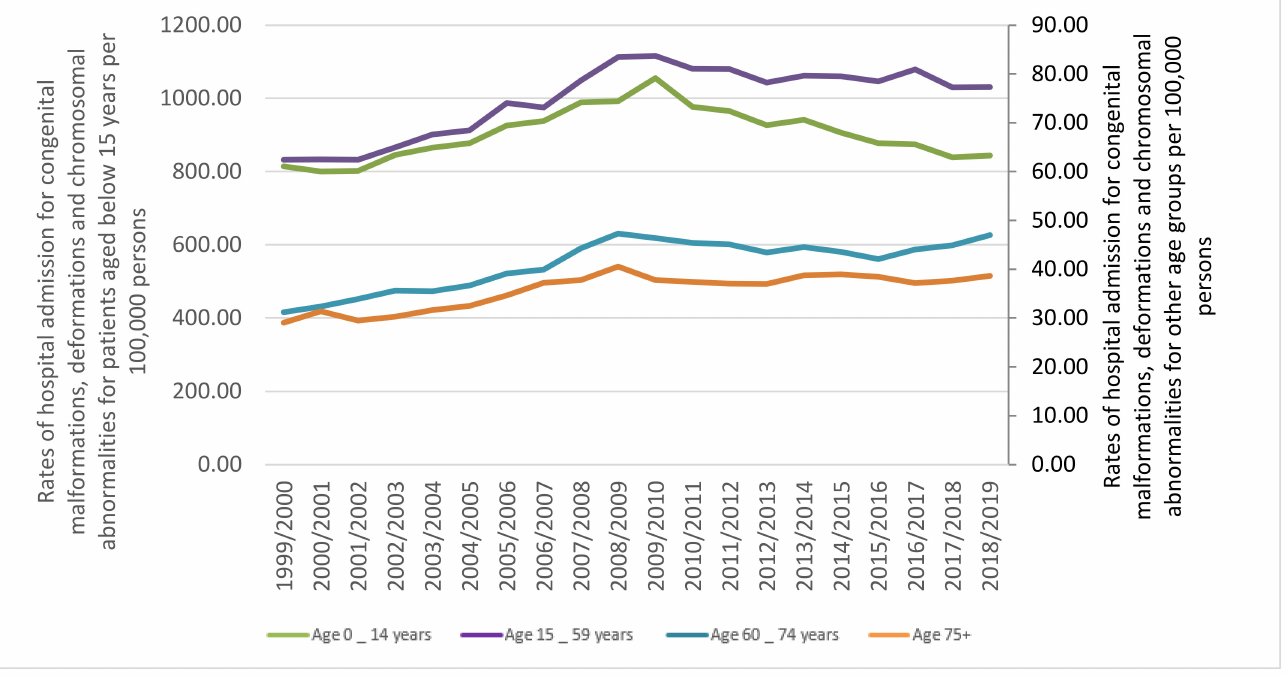
Figure 2. Rates of hospital admission for congenital malformations, deformations and chromosomal abnormalities in England and Wales stratified by age